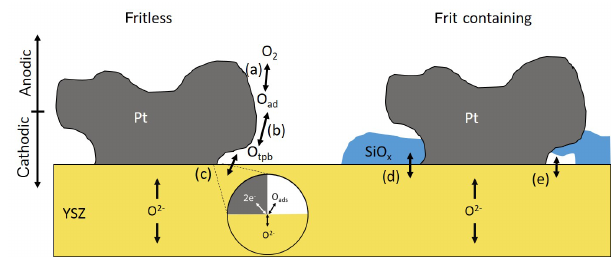
Figure 6. Possible processes indicated by (a) – (e) at the Pt | YSZ interface for fritless and frit-containing electrodes.